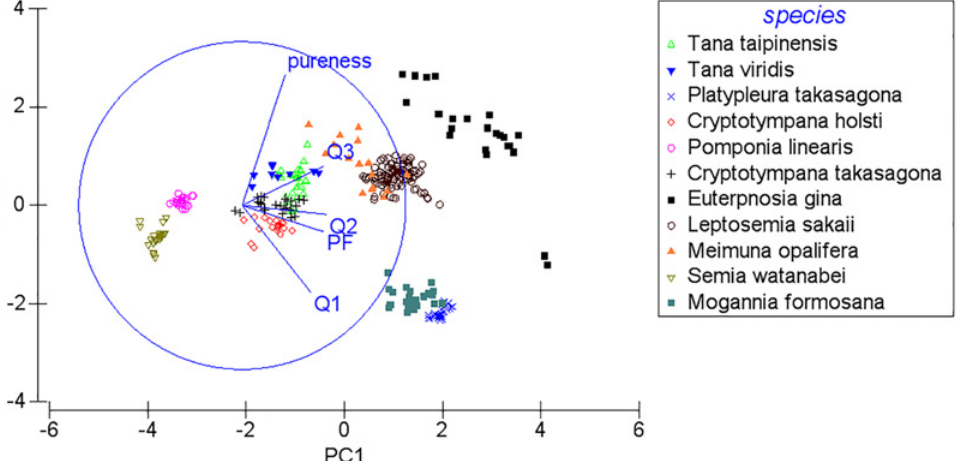
Figure 4. A bi-dimensional plotting of the principal component analysis using the five acoustic variables (PF, Q1, Q2, Q3, pureness) on spectrograms of cicada calling songs at the SP mountain site of